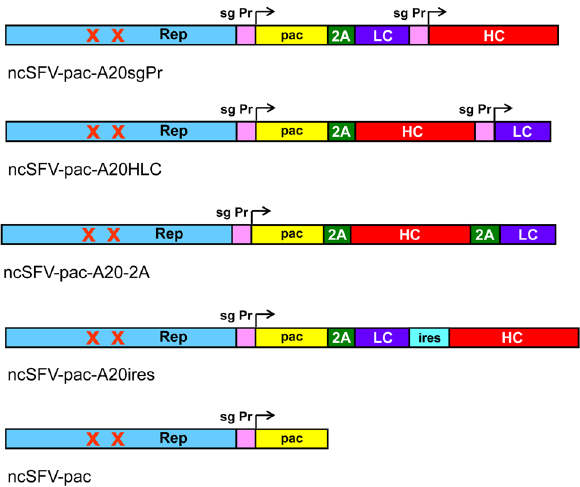
Figure 1. Schematic representation of vectors expressing murine follicular lymphoma-derived A20 mAb. Noncytopathic vectors (ncSFV-pac) contain mutations P718T and R649H in the nsp2 subunit of the replicase (Rep), indicated by two Xs, and express the pac gene downstream of the viral subgenomic promoter (sg Pr). The sequence of the small FMDV 2A autoprotease (2A) was used to fuse the pac gene to genes coding for the heavy (HC) or light chain (LC) of A20 mAb. A second sg Pr, the 2A sequence, or the internal ribosome entry site (IRES) from encephalomyocarditis virus were used to express separately HC and LC as indicated in the